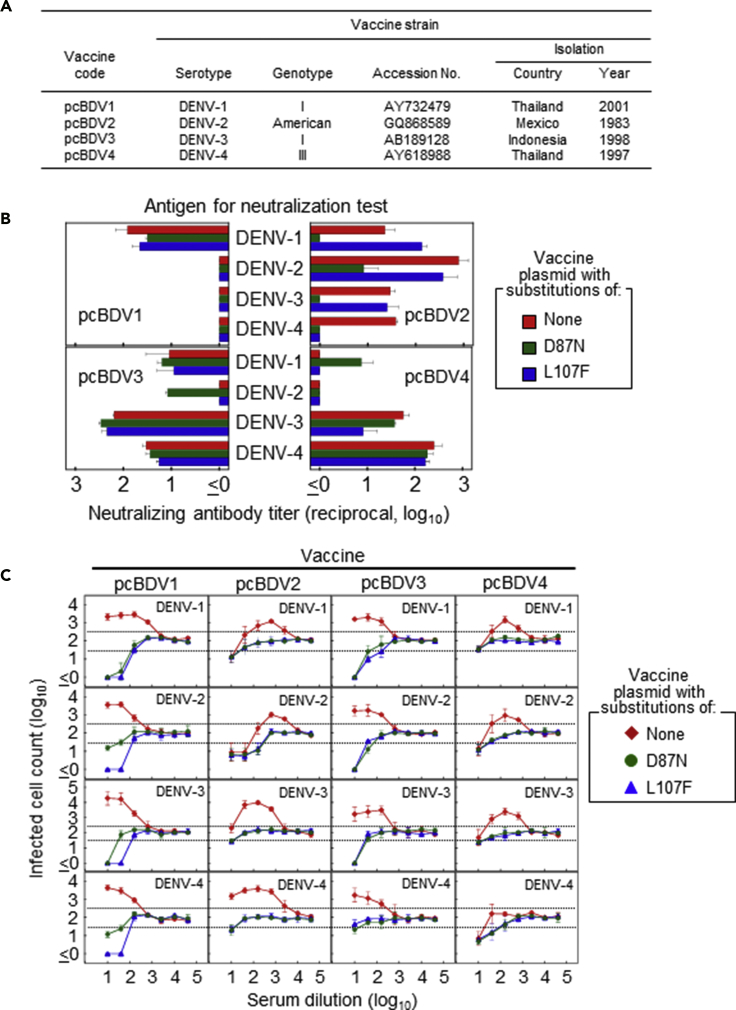
Assessment of EAb Induction Using Strains or Serotypes Other than DENV-1 Mochizuki(A) DENV strains used for constructing DNA vaccines (pcBDV1–pcBDV4) and their variants designed to express E containing amino acid substitutions of D87N or L107F. The genotypes and GenBank accession numbers are provided followed by the countries and years in which the strains were isolated. Each DNA plasmid is defined by the vaccine code of pcBDV-1, pcBDV-2, pcBDV-3, or pcBDV-4; all DNA plasmids were constructed based on the pcDNA3 vector.(B and C) NAb titers (B) and enhancing activities (C) induced in mice (females were used for this experiment) immunized with each of pcBDV1–pcBDV4 or their variants. (B) PRNT75 antibody titers were obtained from two independent experiments. The x axis shows the serum dilutions corresponding to the PRNT75 value. (C) Enhancing activities were obtained from two independent experiments. The x axis shows the serum dilution, and the y axis displays the infected cell counts (in log10). Labels in panels indicate serotypes of assay antigens. For dotted lines, see the legend of Figure 2. Data represent averages of two independent assays ± SD.See also Figure S3.